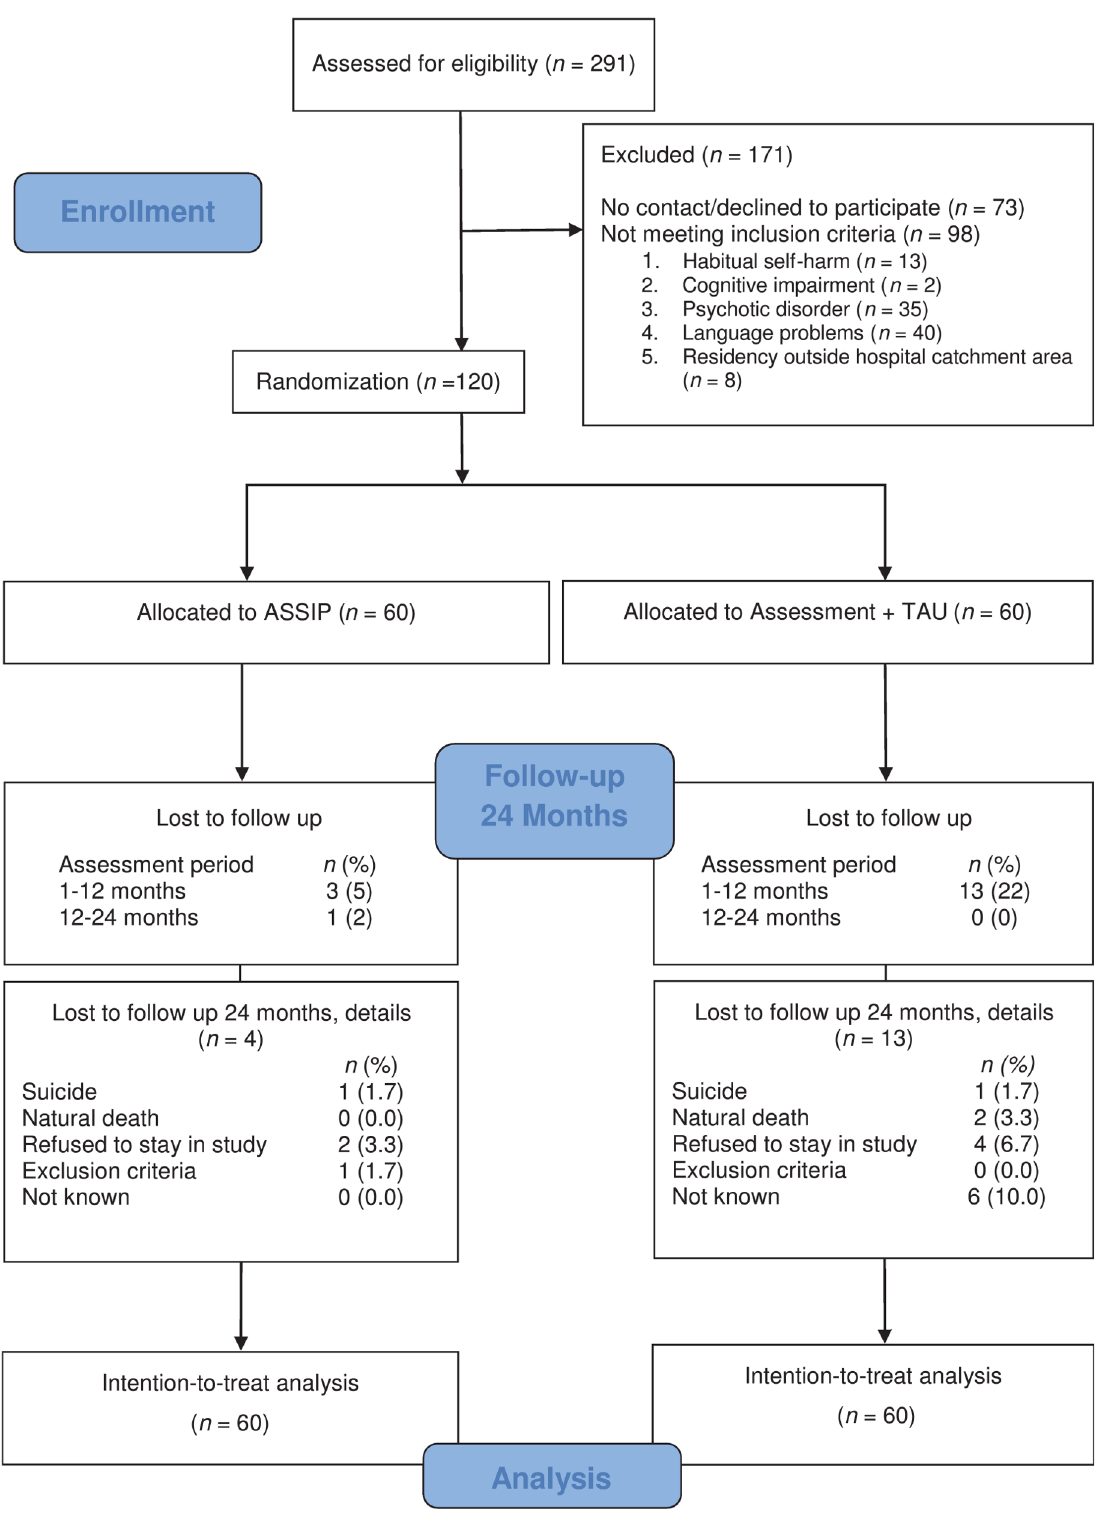
Fig 1. Study flow chart. Flow chart of participants in the randomized controlled trial.